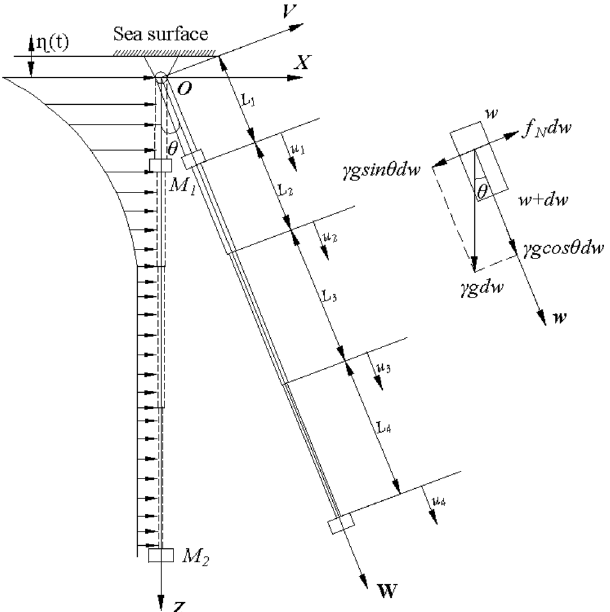
Figure 4. The mechanical model of the lifting pipe subsystem under the action of ocean current (created by AutoCAD 2020 software, URL: https:// www. autod esk. com.